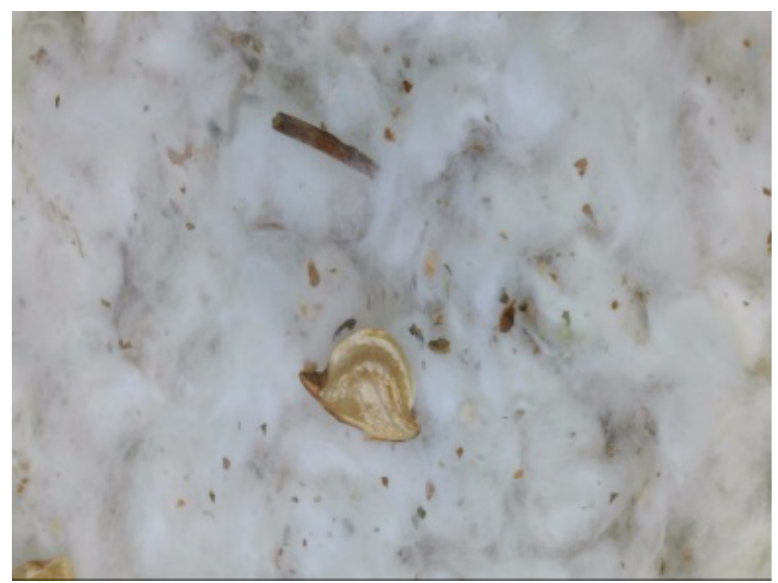
Figure 6. Original image of machine-picked seed cotton. The image segmentation effect of the SVM image segmentation method, k-means clustering segmentation method and multi-channel fusion segmentation method is shown in Figure 7.